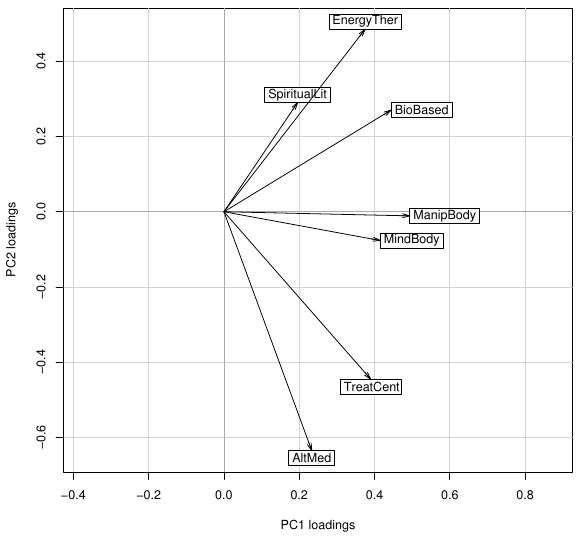
Figure 2 The loadings of the original variables (i.e. number of treatments in each category) for the first two princi- pal components . The weights of the categories are shown in a scatter plot. See also Table 4.